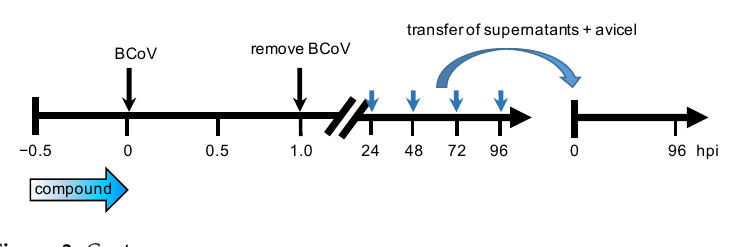
Figure 3. Growth curves in the presence of high-sulfated GAGs. ( A ) Diagram of the experimental settings. ( B ) PT cells were infected with BCoV (MOI 0.00005) in the absence ( w / o ) or presence of 0.2996 µM sHA3 or 1.7156 µM sCS3. At each time point, supernatants were harvested and titers determined on PT cells. Given are mean values and corresponding SD of three independent exper- iments. 3.3. Effects of Pre-, Co- and Post-Treatment To determine the phase of viral replication that is sensitive to the compounds, the effect of time-dependent drug addition was analyzed. PT cells were infected with BCoV (MOI 0.00005) and treated with the substances at EC 50 (sHA3, 0.2996 µM; sCS3, 1.7156 µM) at different times of infection or left untreated. At day four post infection the effect on viral replication was quantified by plaque reduction (Figure 4A). Preincubation of the cells resulted in plaque reduction of approximately 57% for sHA3 and 38% for sCS3 compared to the untreated control (Figure 4B). Similar observations were seen if sHA3 was present during or after viral adsorption (Figure 4B). In contrast, sCS3 showed the most pro- nounced reduction if the compound was added during viral adsorption (58%) and the weakest (20%) by addition after viral adsorption (Figure 4B). These results revealed that sHA3 could be useful not only for prophylactic treatment but also as a therapy for SARS- CoV-infected patients.